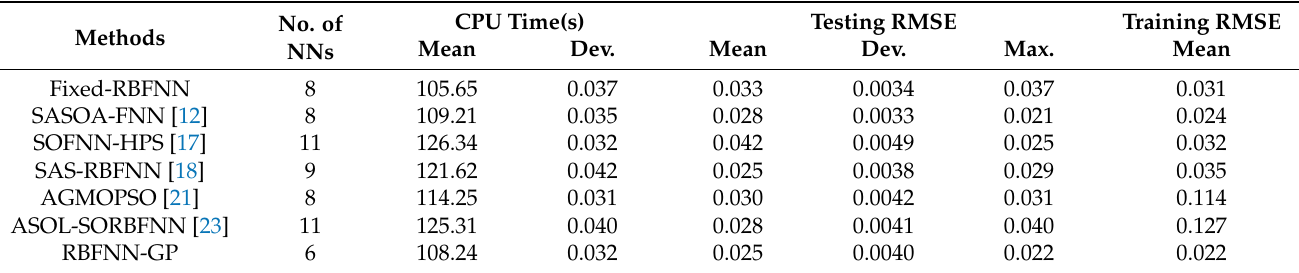
Table 3. Comparison results with other self-organizing